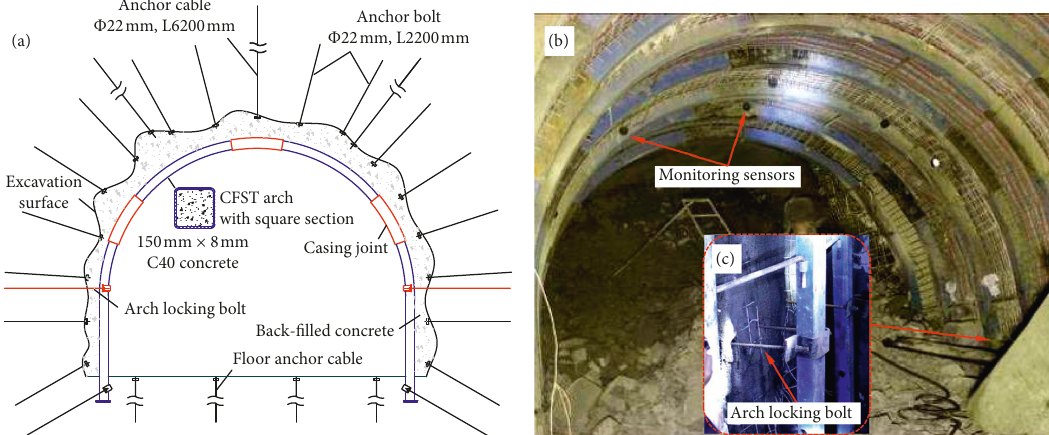
Figure 17: Field test of CFSTarch-bolt composite scheme with arch locking bolts. (a) Supporting scheme with CFSTarches and arch locking bolts. (b) Overall picture of the roadway during construction. (c) Arch locking